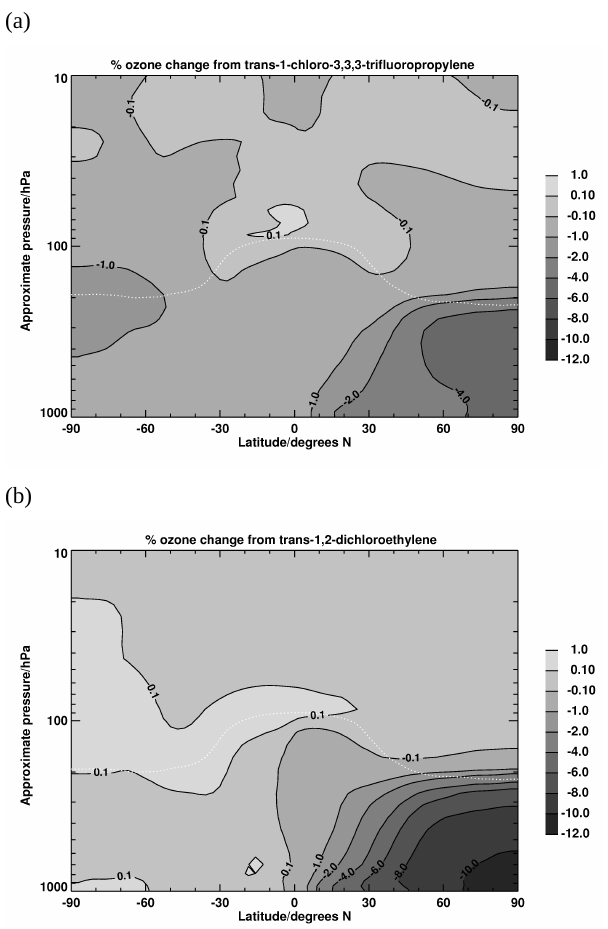
Figure 3. Annual and zonally-averaged percent change in ozone arising from the chloroalkenes in Fig. 3. Annual and zonally-averaged percent change in ozone aris- ing from the chloroalkenes in MOZART 3. (a) tCFP, (b) tDCE. MOZART 3. (a) tCFP, (b) tDCE. or nearly all, of that from tDCE would occur in the tropo- sphere, rather than the stratospheric ozone layer where most of the long-lived ozone-depleting substances cause O 3